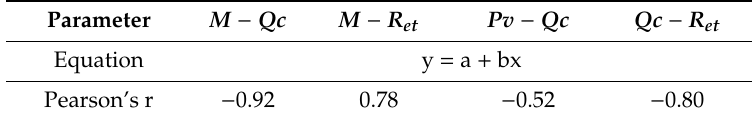
Table 7. Parameters of the strength of the linear relationship between highly correlated properties. Parameter